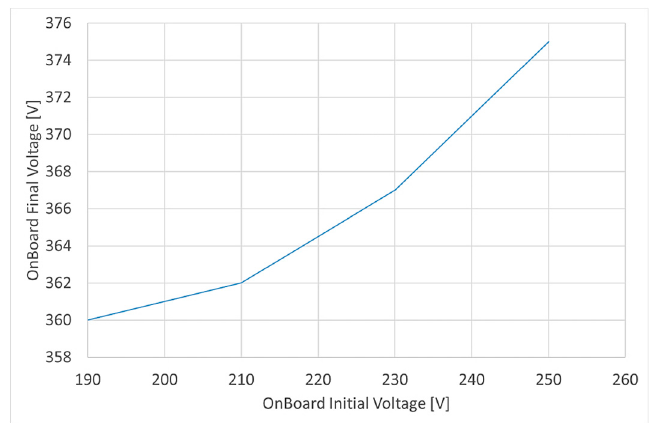
Figure 9. Final onboard supercapacitor voltage as a function of the initial voltage (as recorded before the charging process).